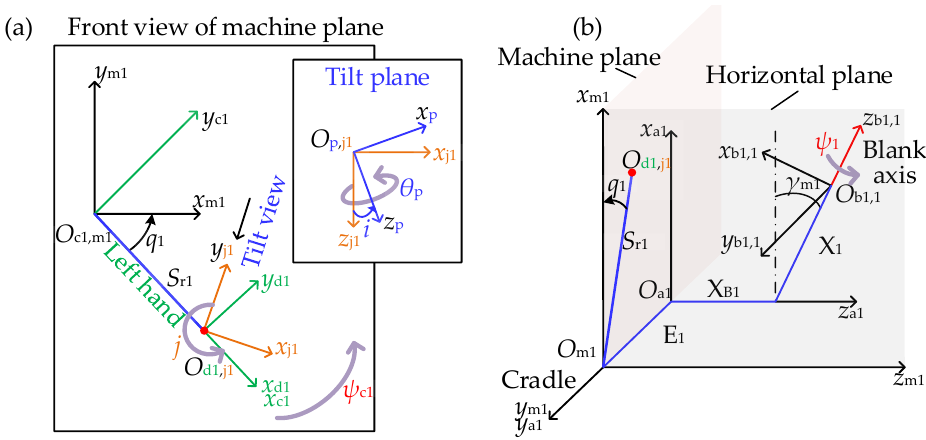
where θ p is the rotation angle of the cutter; i is the tilt angle; j is the swivel angle; S r1 is radial distance; q 1 is the cradle angle; X B1 is the sliding base; E 1 is the blank offset; γ m1 is the machine root angle; X 1 is the machine center to back; ψ 1 is the blank rotation angle; ψ c1 is the cradle rotation angle; and ψ c1 = ψ 1 / i 1, i 1 is the velocity ratio.